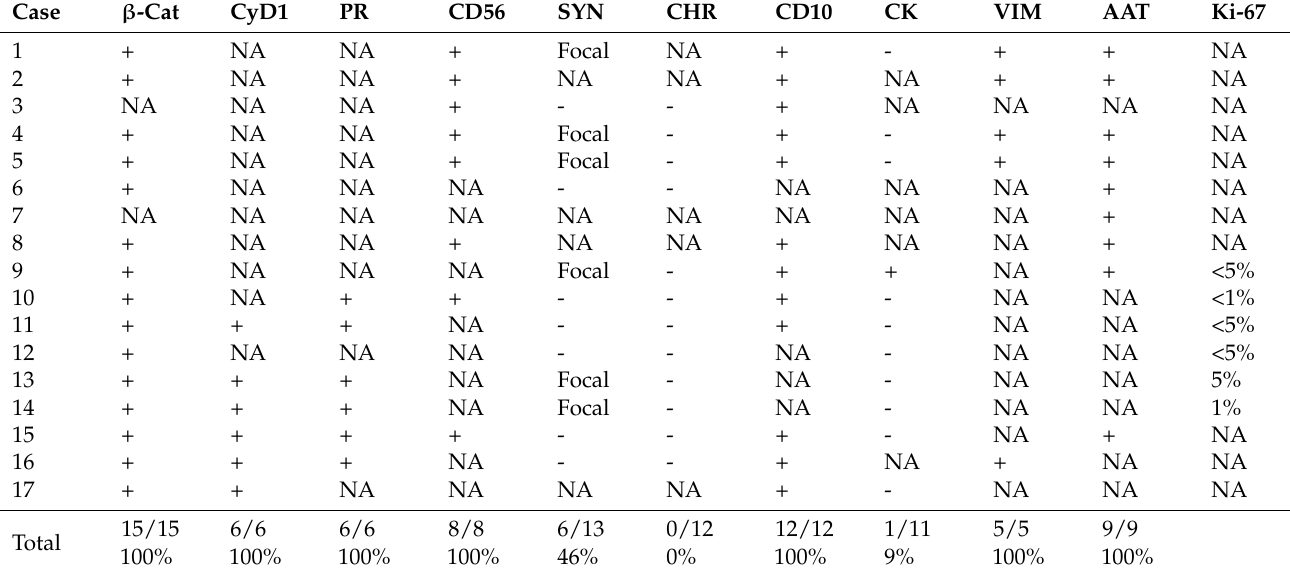
Table 3. SPN: immunohistochemistry profile in cases with cytological